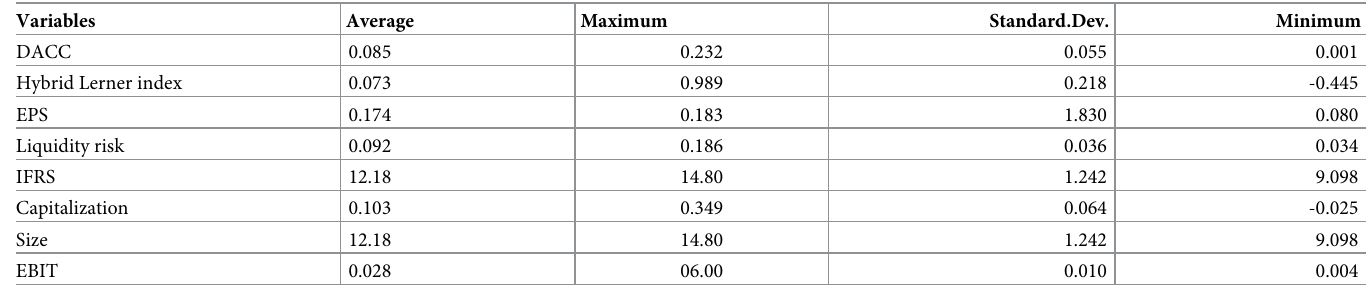
Table 1. Summary